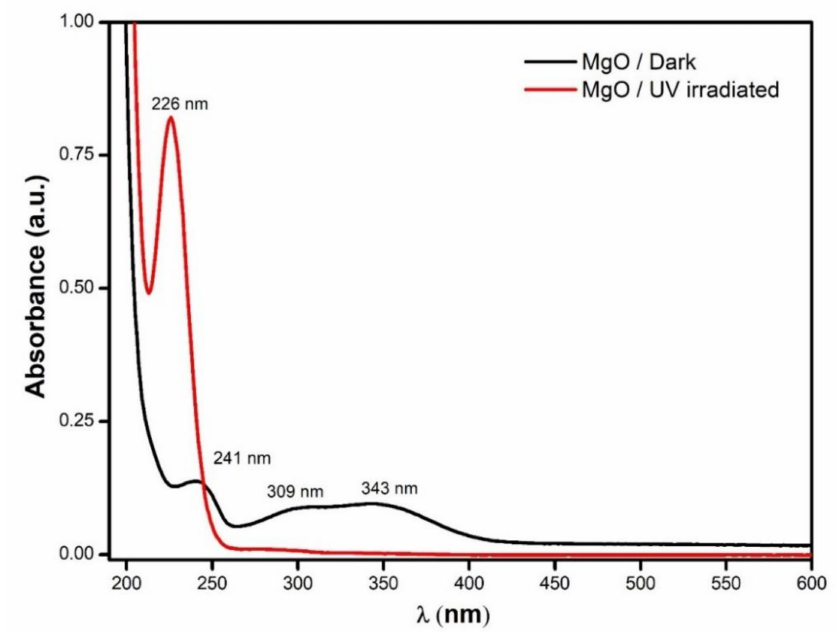
Figure 4. UV–Vis spectra of the MgO nanoparticles when stored in the dark and after irradiation by the UV lamp for 4